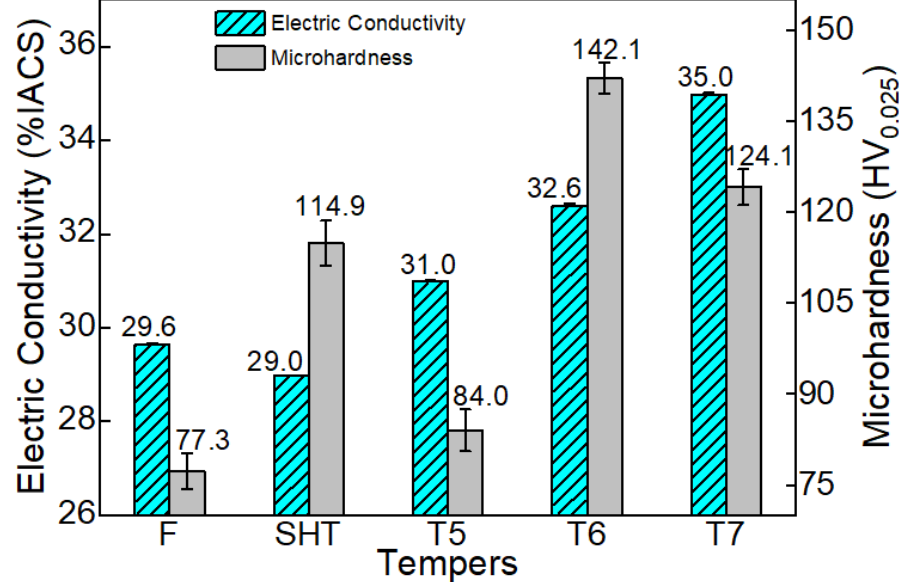
Figure 8. Electrical conductivity and microhardness of the Al-Si-Cu-Mg 319 alloy after different treatments.